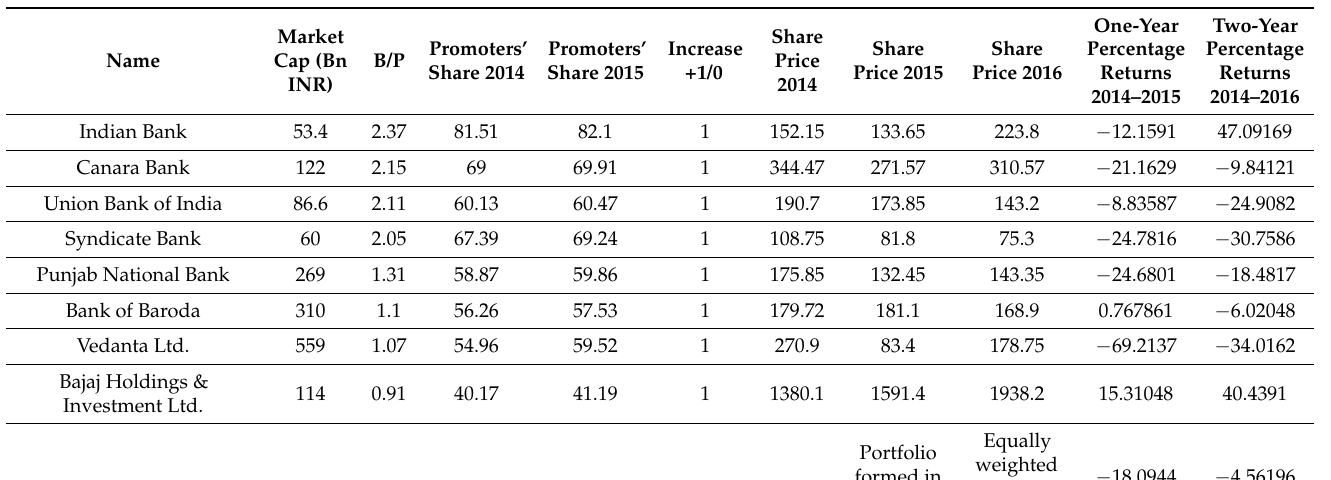
Table 4. Portfolio 2014 (financial details of small-cap companies whose promoter holdings increased in a